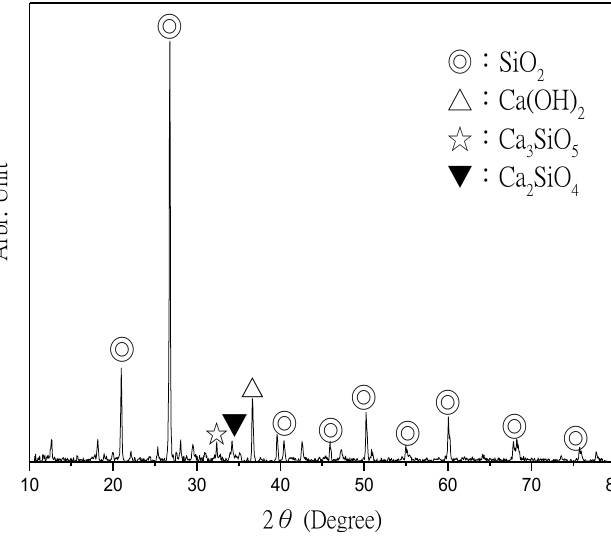
Figure 8. XRD of 20 mm beneath the